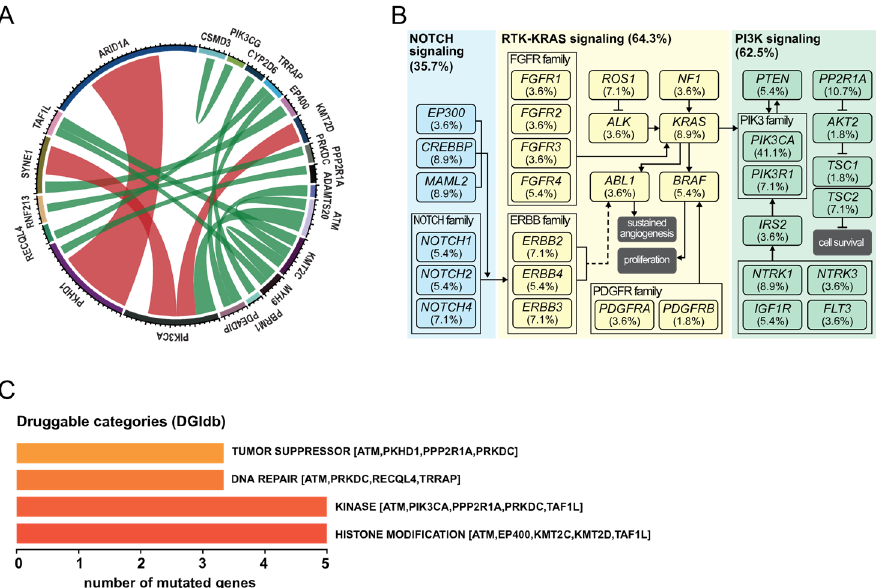
Figure 2. Mutation co-occurrence and pathways misregulation in OCCC. ( A ) Circos plot diagram depicting the pairwise co-occurrence of gene mutations (green arches) or mutual exclusivity (red arches). ( B ) Representation of the most affected pathways, NOTCH (35.7%; blue), RTK-RAS (64.3%; yellow) and PI3K (62.5%; green). Each box represents the mutated gene found in the cohort and its frequency. ( C ) Integrative analysis with DGIdb showing the potential druggable categories. Overall mutational landscape in OCCC.